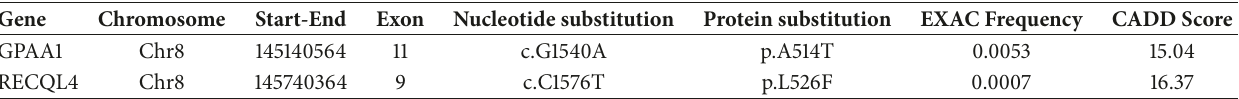
Table 4: GPAA1 and RECQL4 genes both demonstrated a likelihood of being modifier genes of SLC39A4 in developing AE in B03.